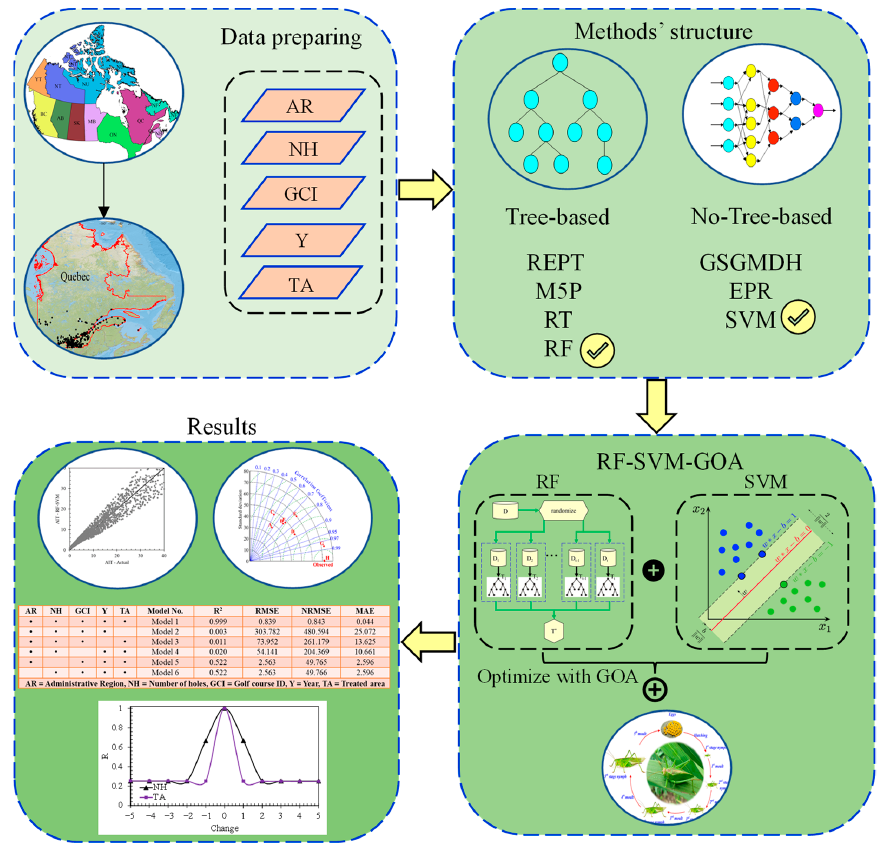
Figure 4. Graphical representation of the results.